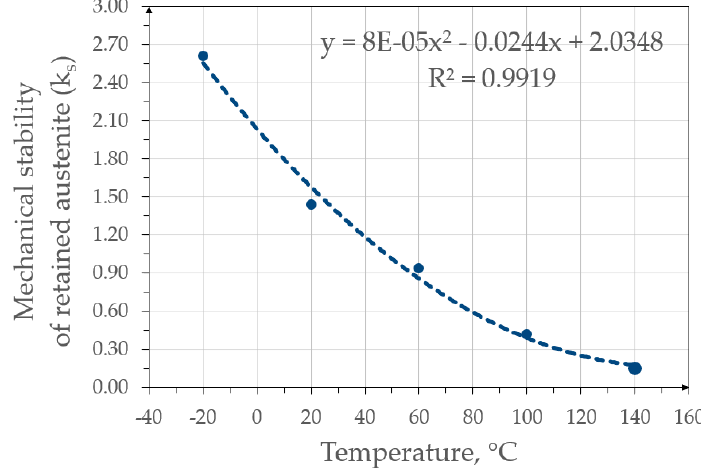
ffi cient as a function of the deformation Figure 9. Graph showing the k s coefficient as a function of the deformation temperature. Figure 9. Graph showing the k s coe